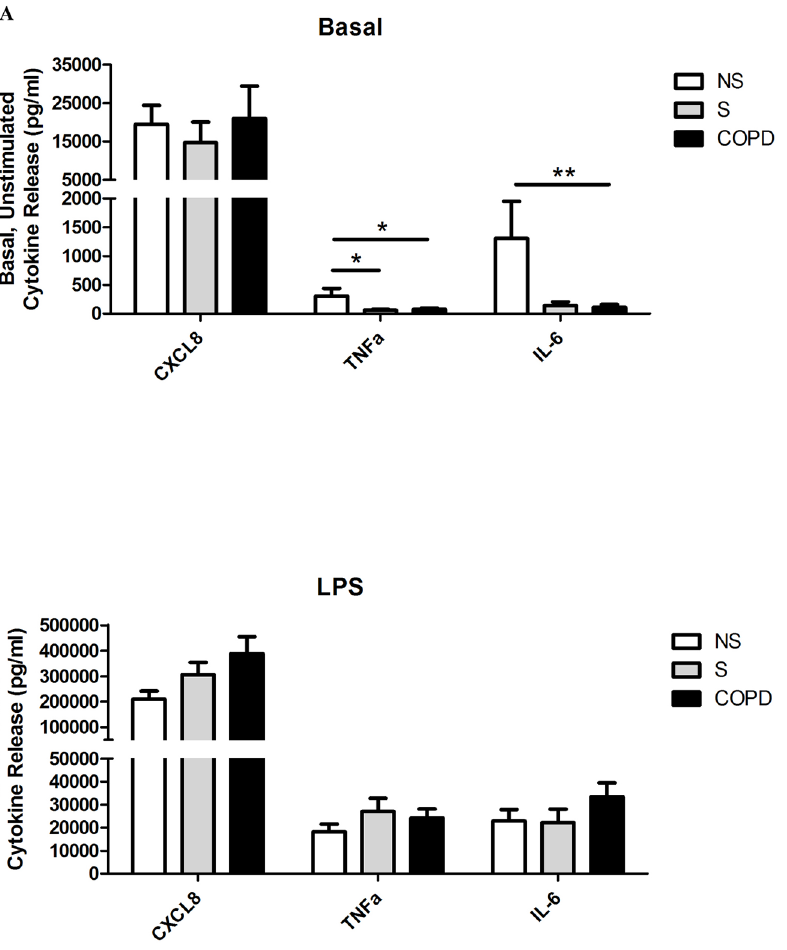
Figure 1. Baseline and LPS-stimulated characteristics of alveolar macrophage supernatants. Lung macrophages were incubated either with or without LPS (1 m g/ml) for 24 h with 17-BMP (0.01–100 nM). Data shown are mean 6 SEM for CXCL8, TNF a and IL-6 ELISAs of baseline (A) and LPS-stimulated (B) supernatants. COPD (n=25), S (n=11) and NS (n=8) shown. One-way ANOVAs were performed on all data sets, and when P , 0.05 two-tailed t-tests were subsequently performed which are shown on the graph; * P , 0.05, ** P ,